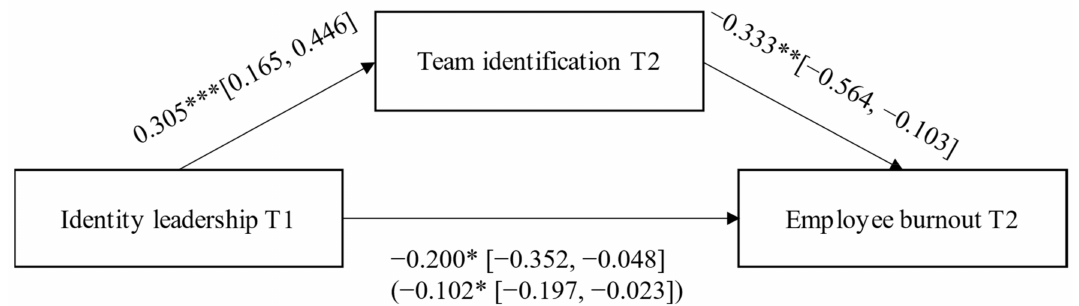
Figure 2. Mediation model with direct effects and the indirect effect (in parentheses) for German two-wave data. Note: * p < 0.05; ** p < 0.01; *** p <